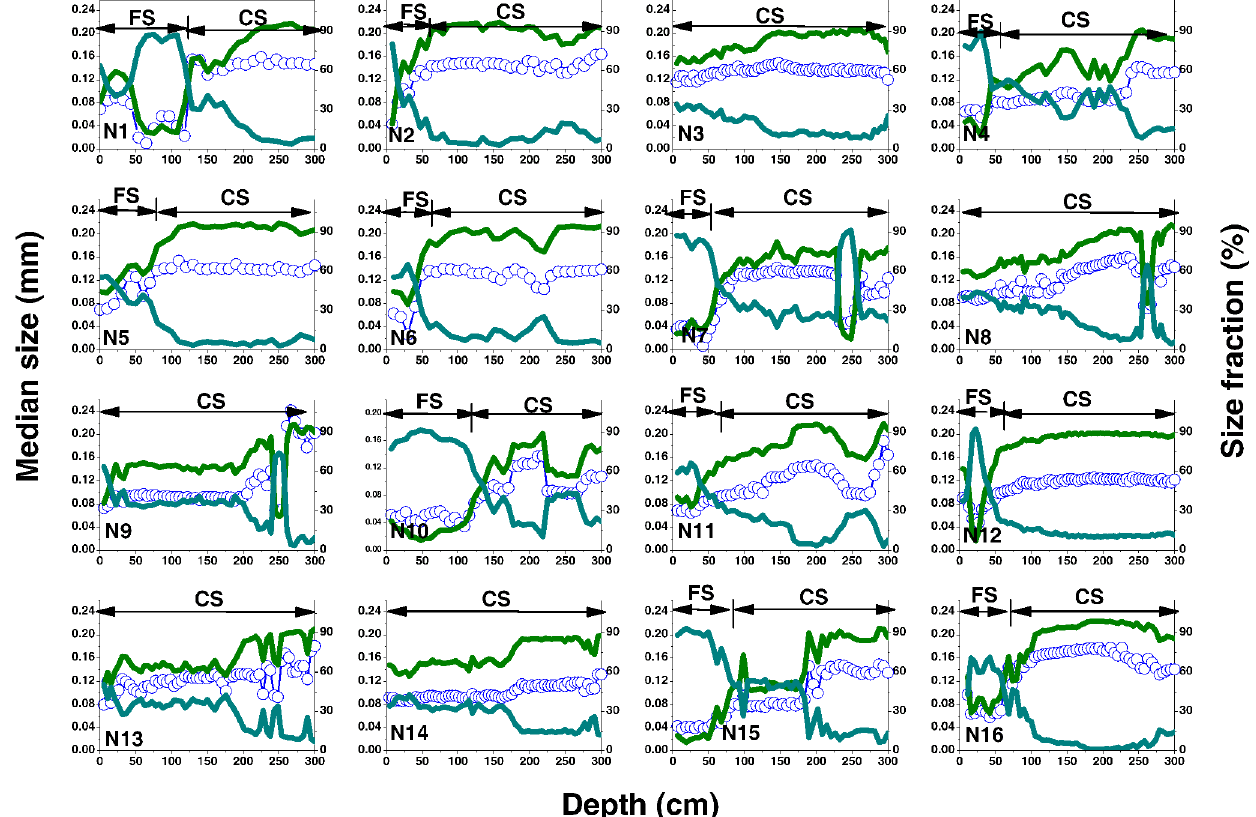
Figure 4. Vertical distributions of portions of the two-fraction sediments ( > 0.08mm and < 0.08mm) and the related median sizes in 16 sediment cores (N1–N16, see in Fig. 1b) in the channel bars in the Ulan Buh desert braided channel. Olive-green lines depict curves of the portions of the > 0.08mm sediments, dark cyan lines depict curves of the portions of the < 0.08mm sediments and blue circles depict curves of the median sizes of